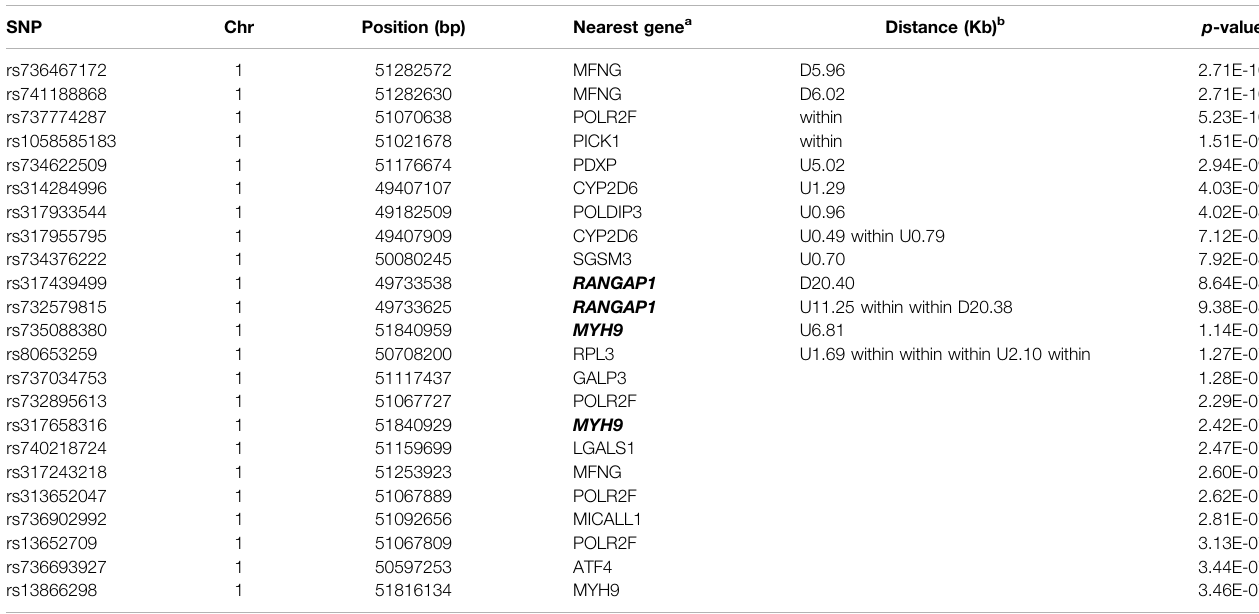
TABLE 1 | Signi fi cant SNPs with p ≤ 4.32 × 10 − 7 from